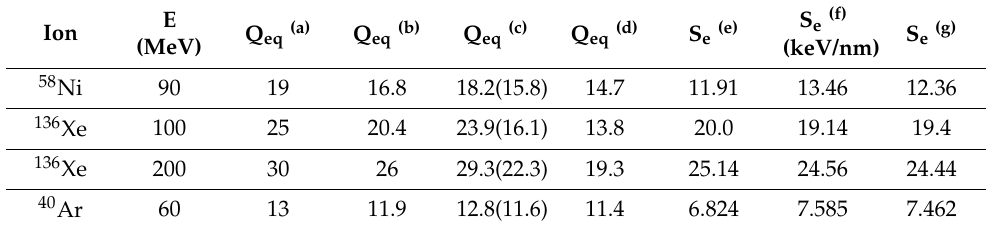
Figure 3. XRD intensity degradation of the diffraction angle of ~48° (o, ●), 23° (x, □) and the electronic sputtering yields (∆, + ) by irradiation of ions with the equilibrium-charge incidence as the function of the electronic stopping power S e , which are calculated by TRIM 1997 [1] (o, x, ∆) and CasP [55] (●, □, +). Power law fits to the XRD degradation (~48°) Y XRD and the electronic sputtering yield Y SP are indicated by the dot lines. From [49]. Table 3. Ion, energy (E in MeV), equilibrium charge (Q eq ), electronic stopping power (S e in